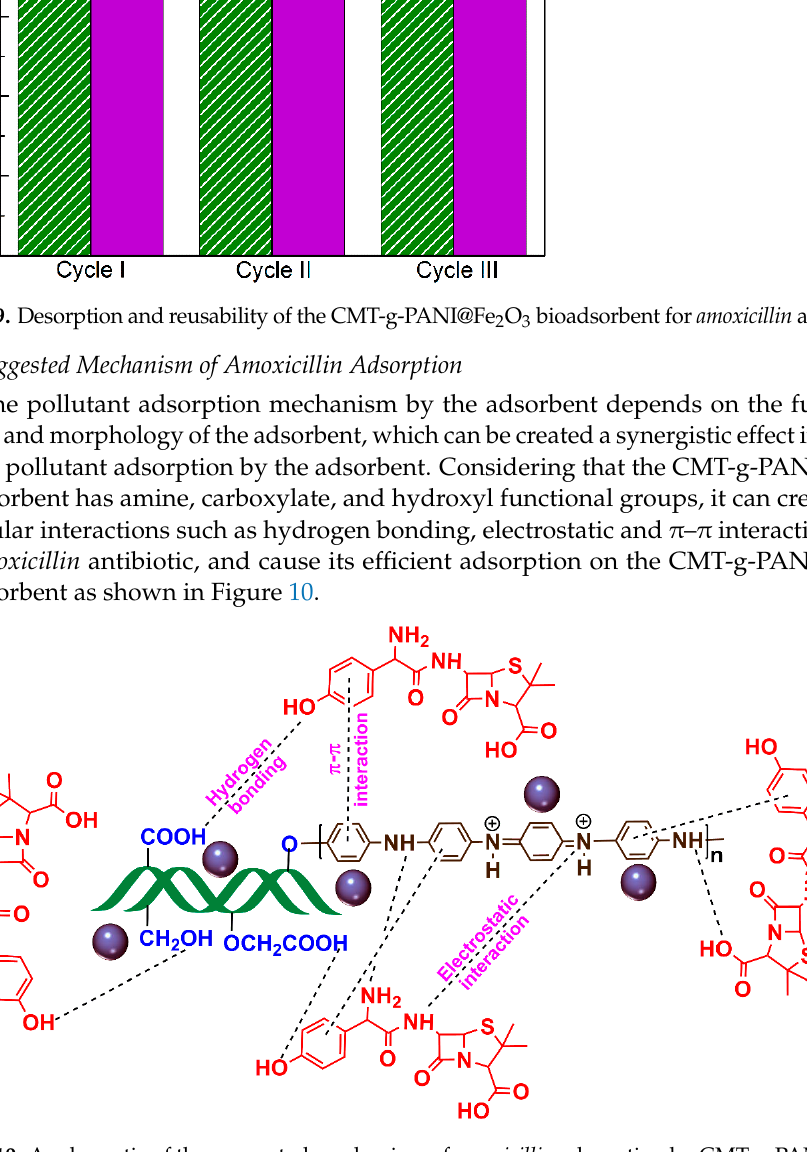
Figure 10. A schematic of the suggested mechanism of amoxicillin adsorption by CMT- g - PANI@Fe 2 O 3